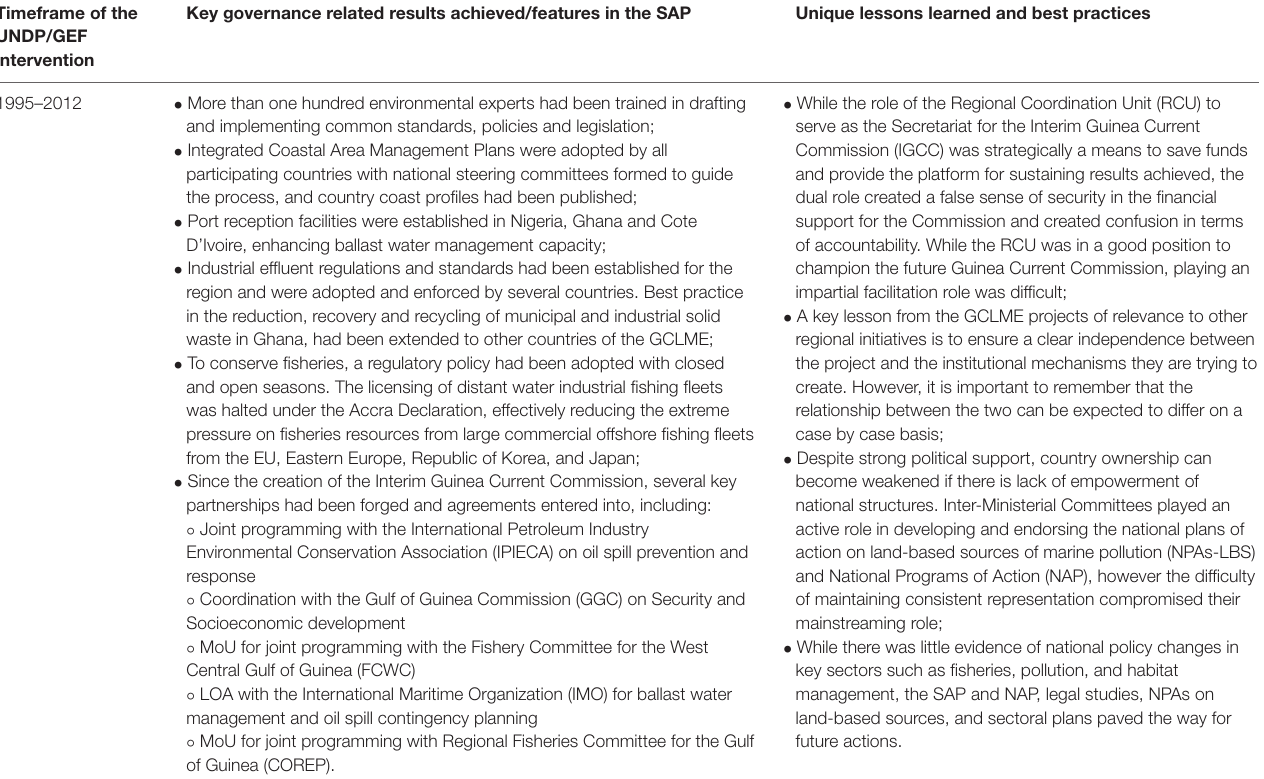
TABLE 3 | Highlighted results of the TDA-SAP process and LME Approach in the Guinea Current LME, as well as unique lessons learned from the intervention (Humphrey and Gordon, 2012; United Nations Environment Programme, 2017). Timeframe of the Key governance related results achieved/features in the SAP Unique lessons learned and best UNDP/GEF intervention